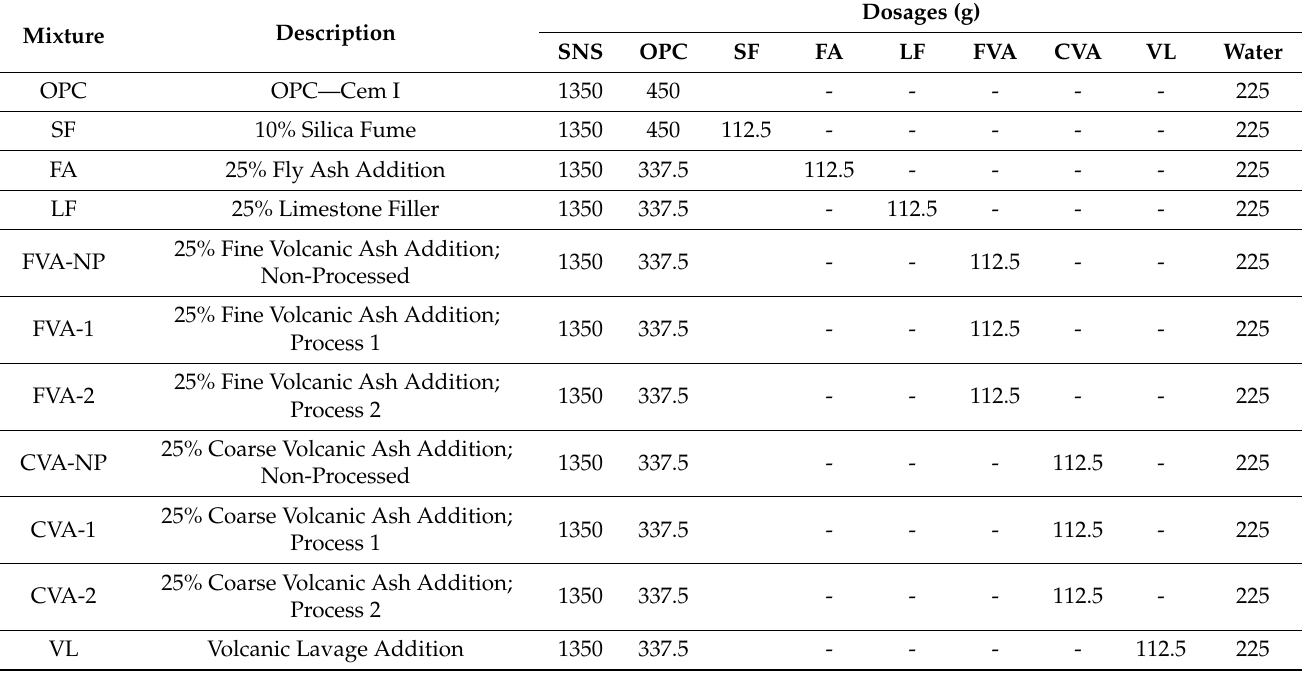
Table 6. Dosages of mortar made in